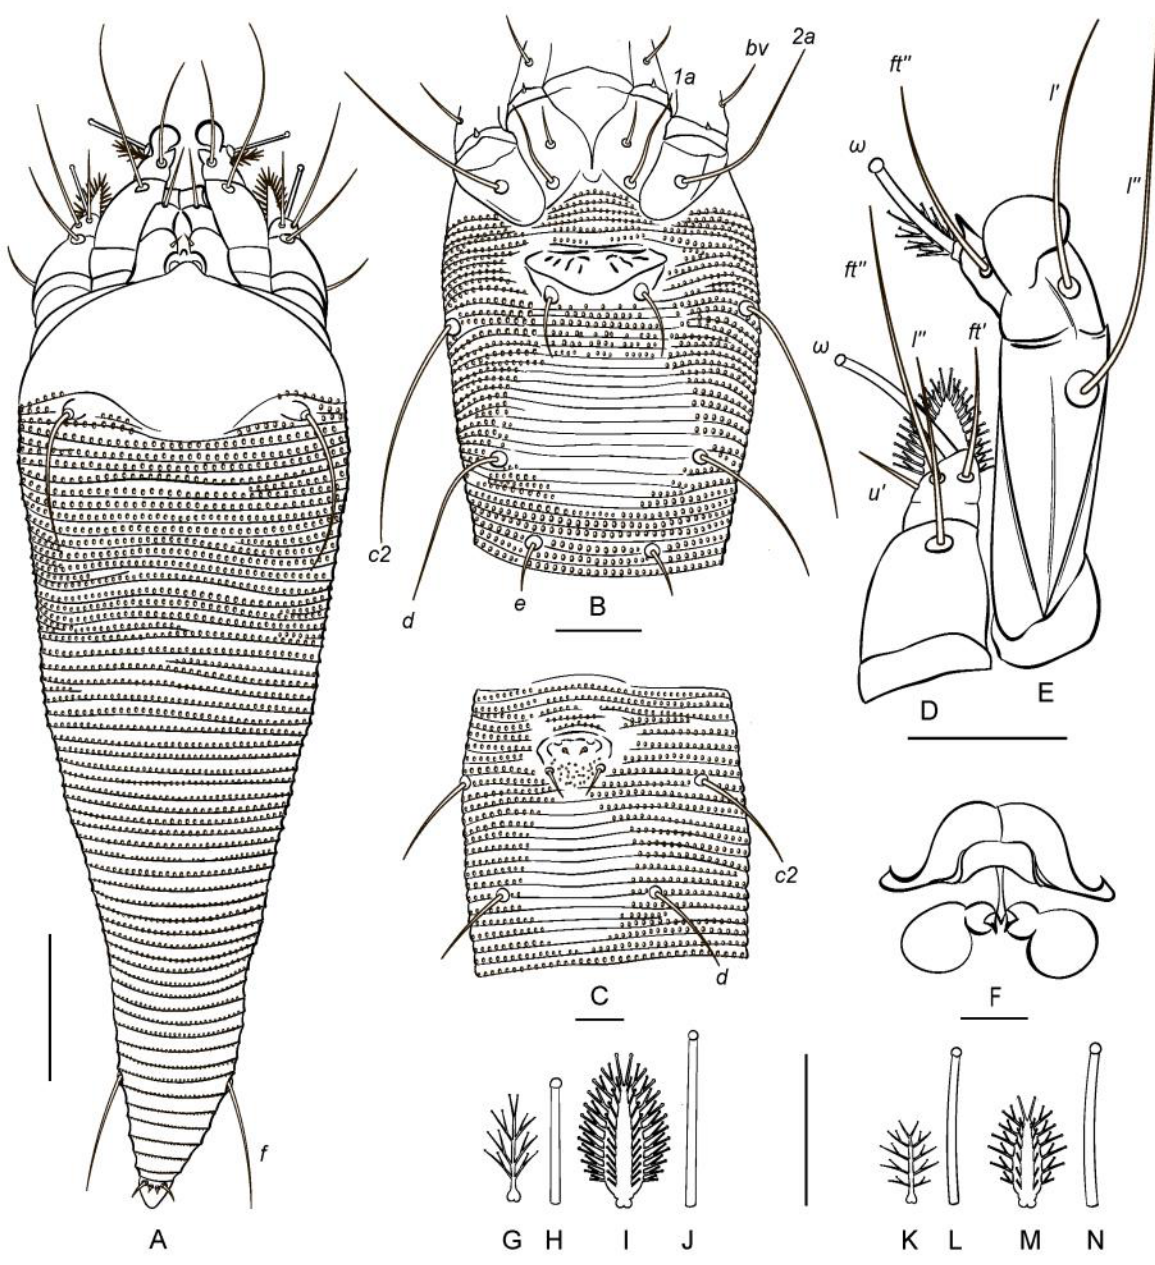
Figure 3. Drawings of female ( A , B , D – J ) and male ( C , K – N ) of Aberoptus schotiae n. sp.